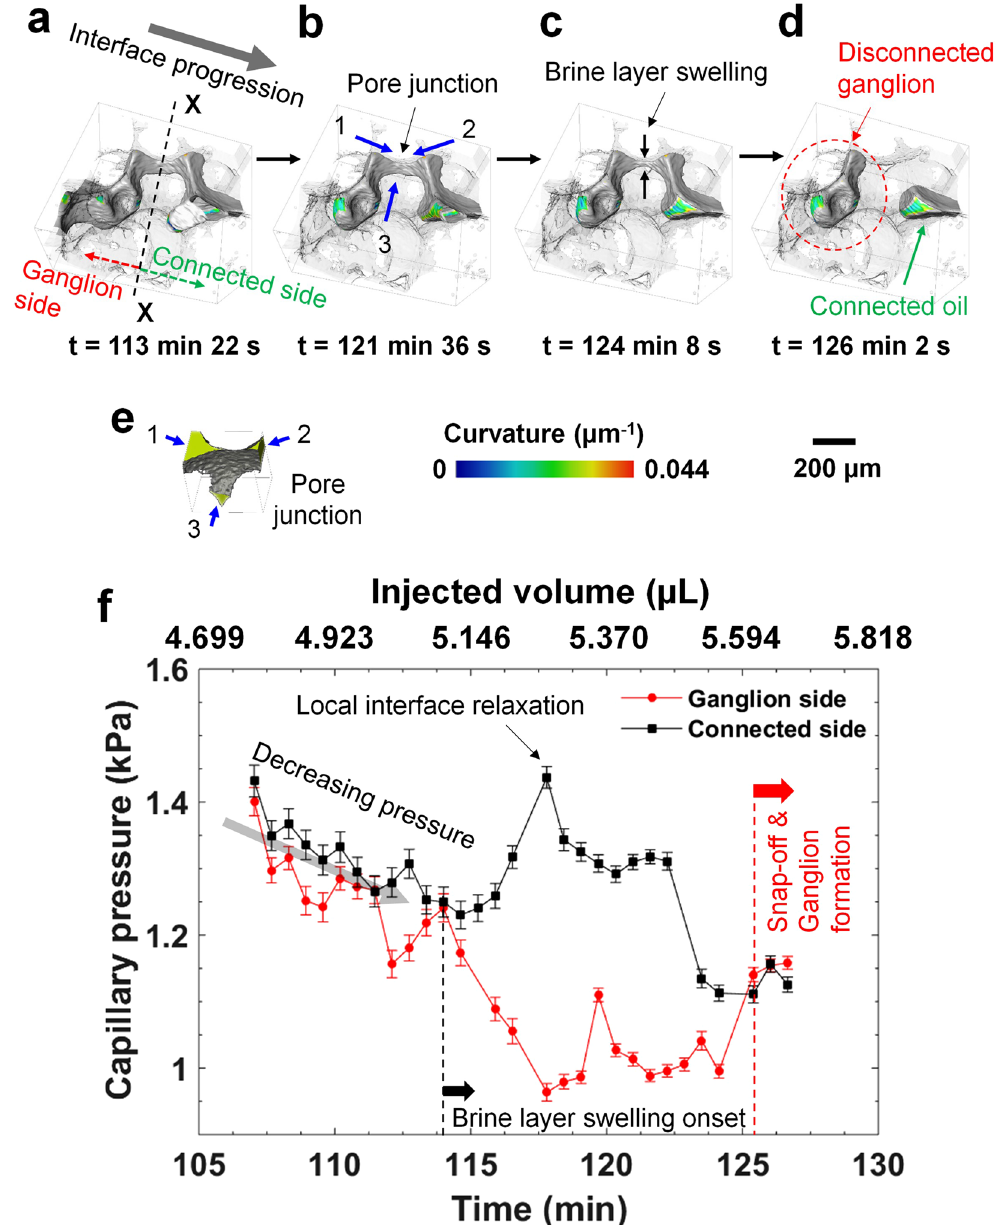
Figure 3. Snap-off during imbibition at a pore junction – Case-I. Various time steps during brine injection showing displacement of oil and trapping: ( a ) t = 113 min 22 s (injected volume = 5.073 µ L), ( b ) t = 121 min 36 s (injected volume = 5.442 µ L), ( c ) t = 124 min 8 s (injected volume = 5.555 µ L), and ( d ) t = 126 min 2 s (injected volume = 5.640 µ L). Time ‘t = 0’ denotes the start of the imbibition process (after acquiring the first tomographic image in imbibition). Each time (t) represents the end of each tomographic image acquisition. ( e ) Location of the pore junction where the snap-off occurred. ( f ) Capillary pressure in the ganglion and connected side is plotted against time and injected